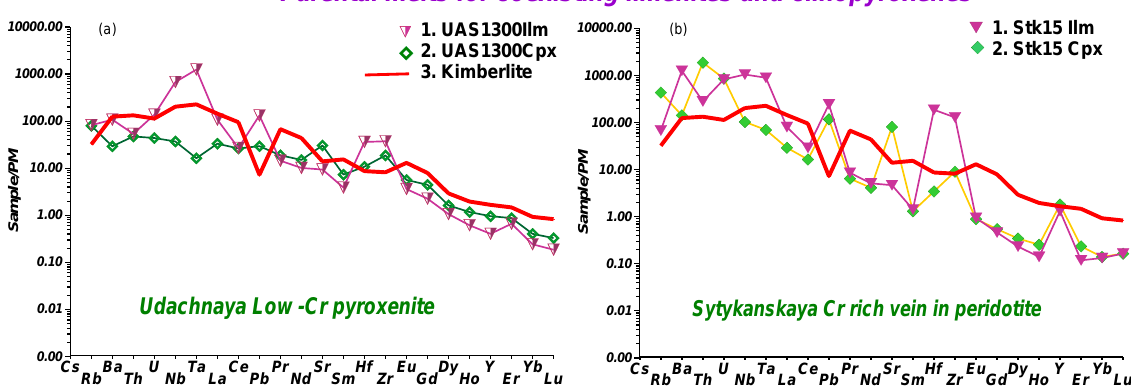
Figure 15. Parental melts for the coexisting ilmenites and clinopyroxenes from low-Cr pyroxenite (UAS1300) (Udachnaya pipe) and meta- somatic vein in peridotite xenoliths from the Sytykanskaya pipe (Stk15). Trace element pattern for the Yubileinaya kimberlite (Kostrovitsky et al., 2007) is given for the